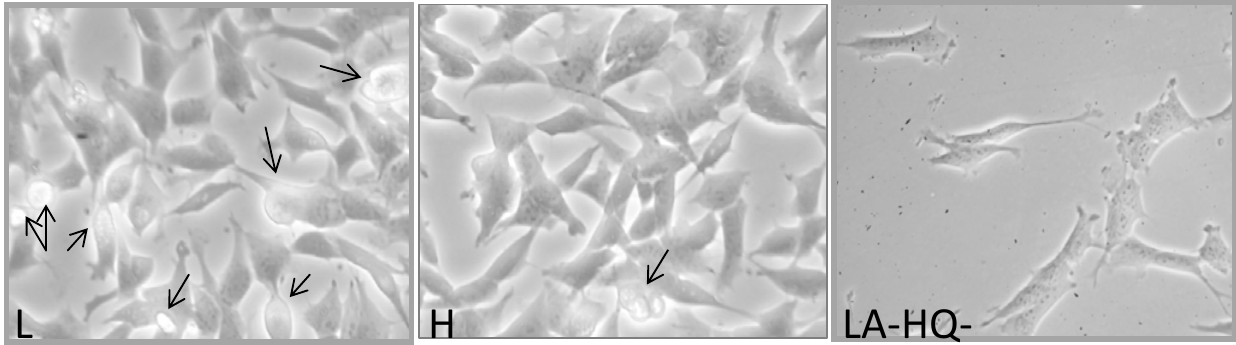
Figure 2. Morphological analysis of undifferentiated SH-SY5Y human neuroblastoma cells in the presence of LA, HQ, and LA-HQ-LA.